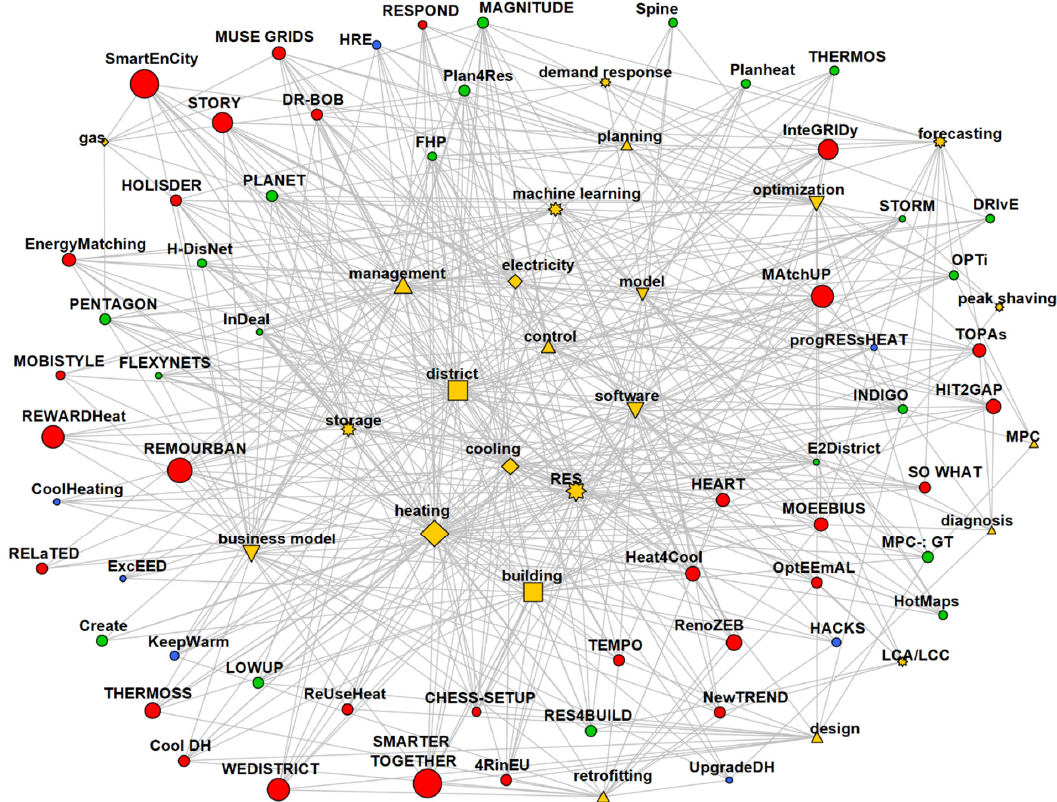
Figure 9. Interconnections between the selected projects and their relevant features. The circles represent the projects (red for IA, green for RIA, blue for CSA), with the size proportional to the funding amount. The yellow symbols represent the features, with the size proportional to the number of interconnections with the projects. The detailed explanation of the features is reported in Table 1. The circles correspond to the selected Horizon 2020 projects with the diameter proportional to the amount of funding (with reference to the data collected in Table A1). The color of the circle indicates the type of funding scheme, where red, green and blue stand for IA, RIA and CSA, respectively. Each project is linked to the involved features, represented by the yellow symbols. The shape of the symbols corresponds to a different feature category with reference to Table 1 (i.e., diamond for energy vector, square for application, inverted triangle for main outcome, triangle for purpose and star for other features). The size of each symbol is proportional to the number of interconnections and, consequently, to the number of projects that directly tackle the feature. The largest cluster of characteristics include heating applications at district and building level by means of software packages, simulation models, and business models, with the purpose of smart management and control, often involving machine learning and RES integration. Since they are key issues of smart DHCs, this is coherent with the scope of this work. Promising features such as demand response, peak shaving, MPC, and fault detection for heating networks are on the edges of the map and deserve future in-depth analysis. It also emerges from the graph that the projects with the largest budgets, in some cases higher than EUR 10 million, are all IA and involve technology demonstration on a large scale. The comparative analysis outlined in this section resulted in some final thematic considerations concerning the real-time control of the system. Apart from the already cited STORM project [33], other interesting outputs are as follows: